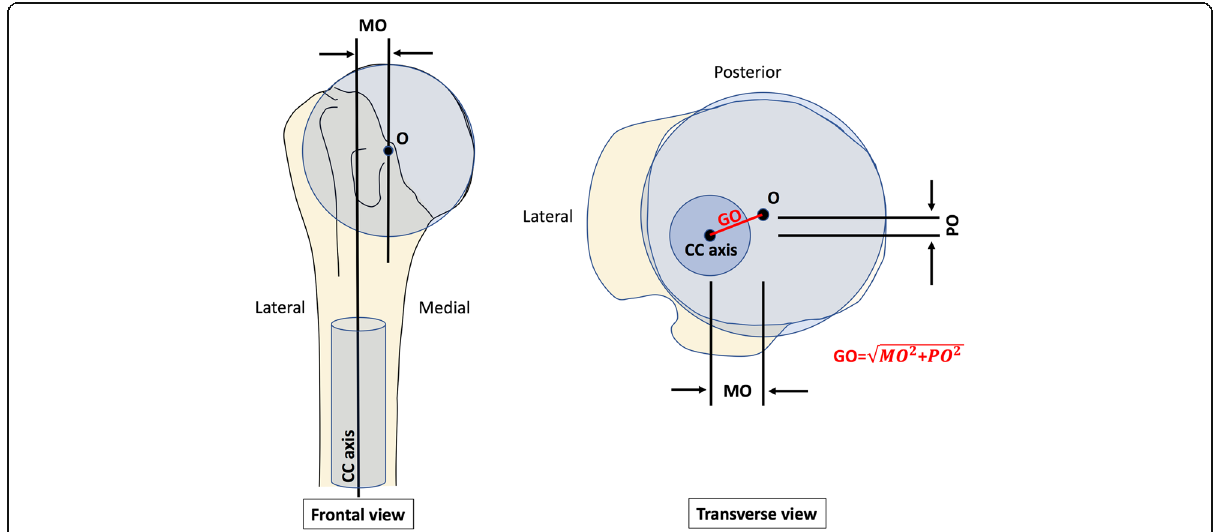
Fig. 3 Determination of the medial and posterior components of humeral head offset between the center of the humeral head (O) and the intramedullary canal axis (CC axis). MO, Medial Offset; PO, Posterior Offset; GO, Global Offset